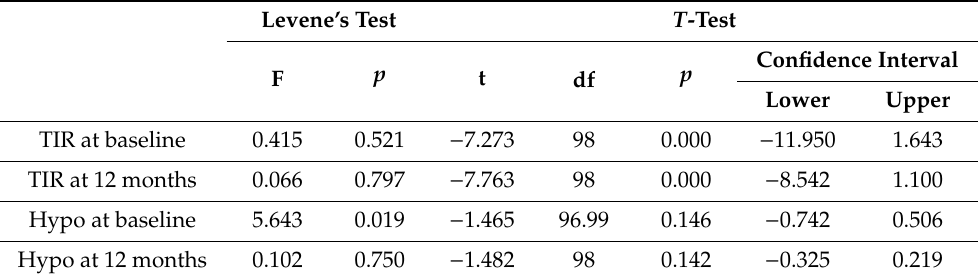
Table 3. T -test for TIR and Hypo–insulin pump versus